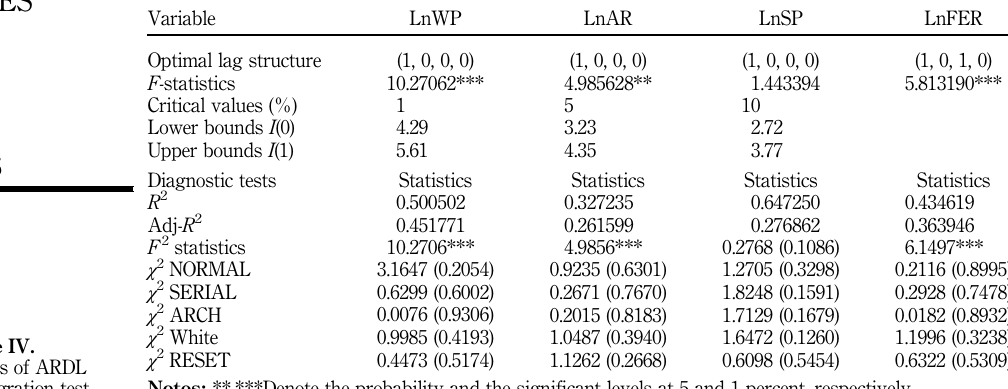
cointegration test